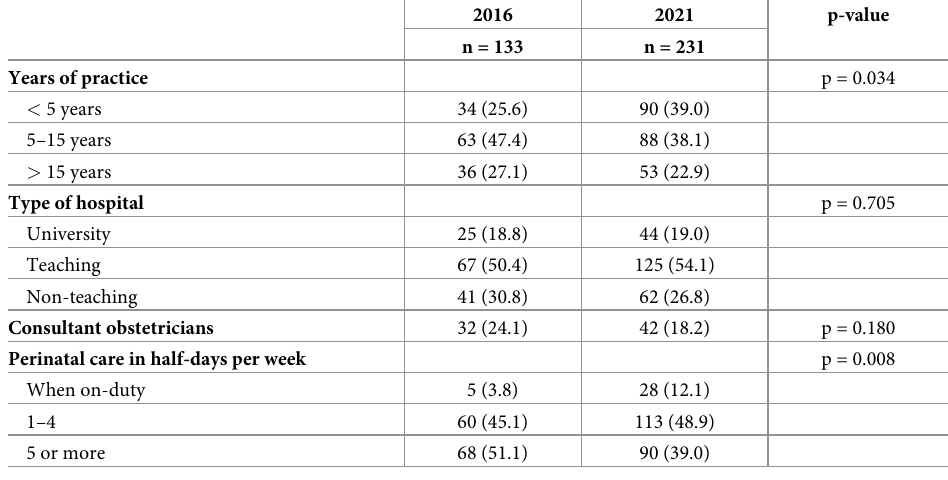
Table 1. Characteristics of the responding gynecologists and residents in 2016 and